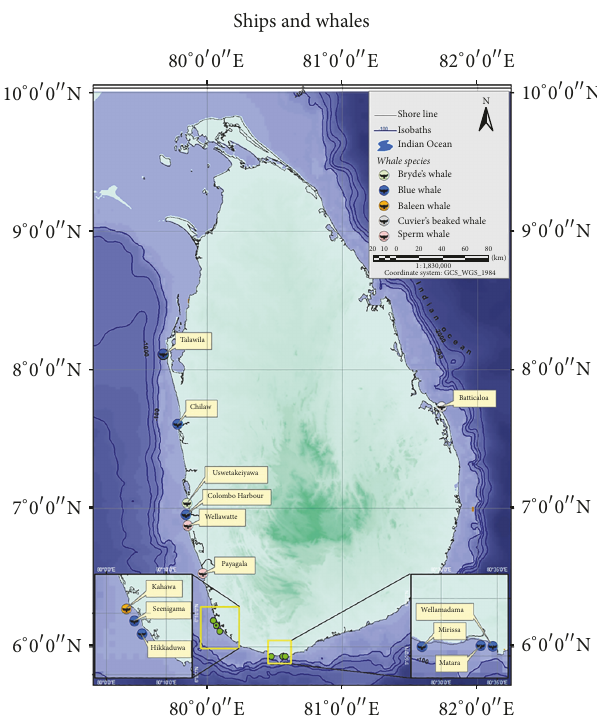
Figure 5: Locations of the stranding recorded around Sri Lanka.